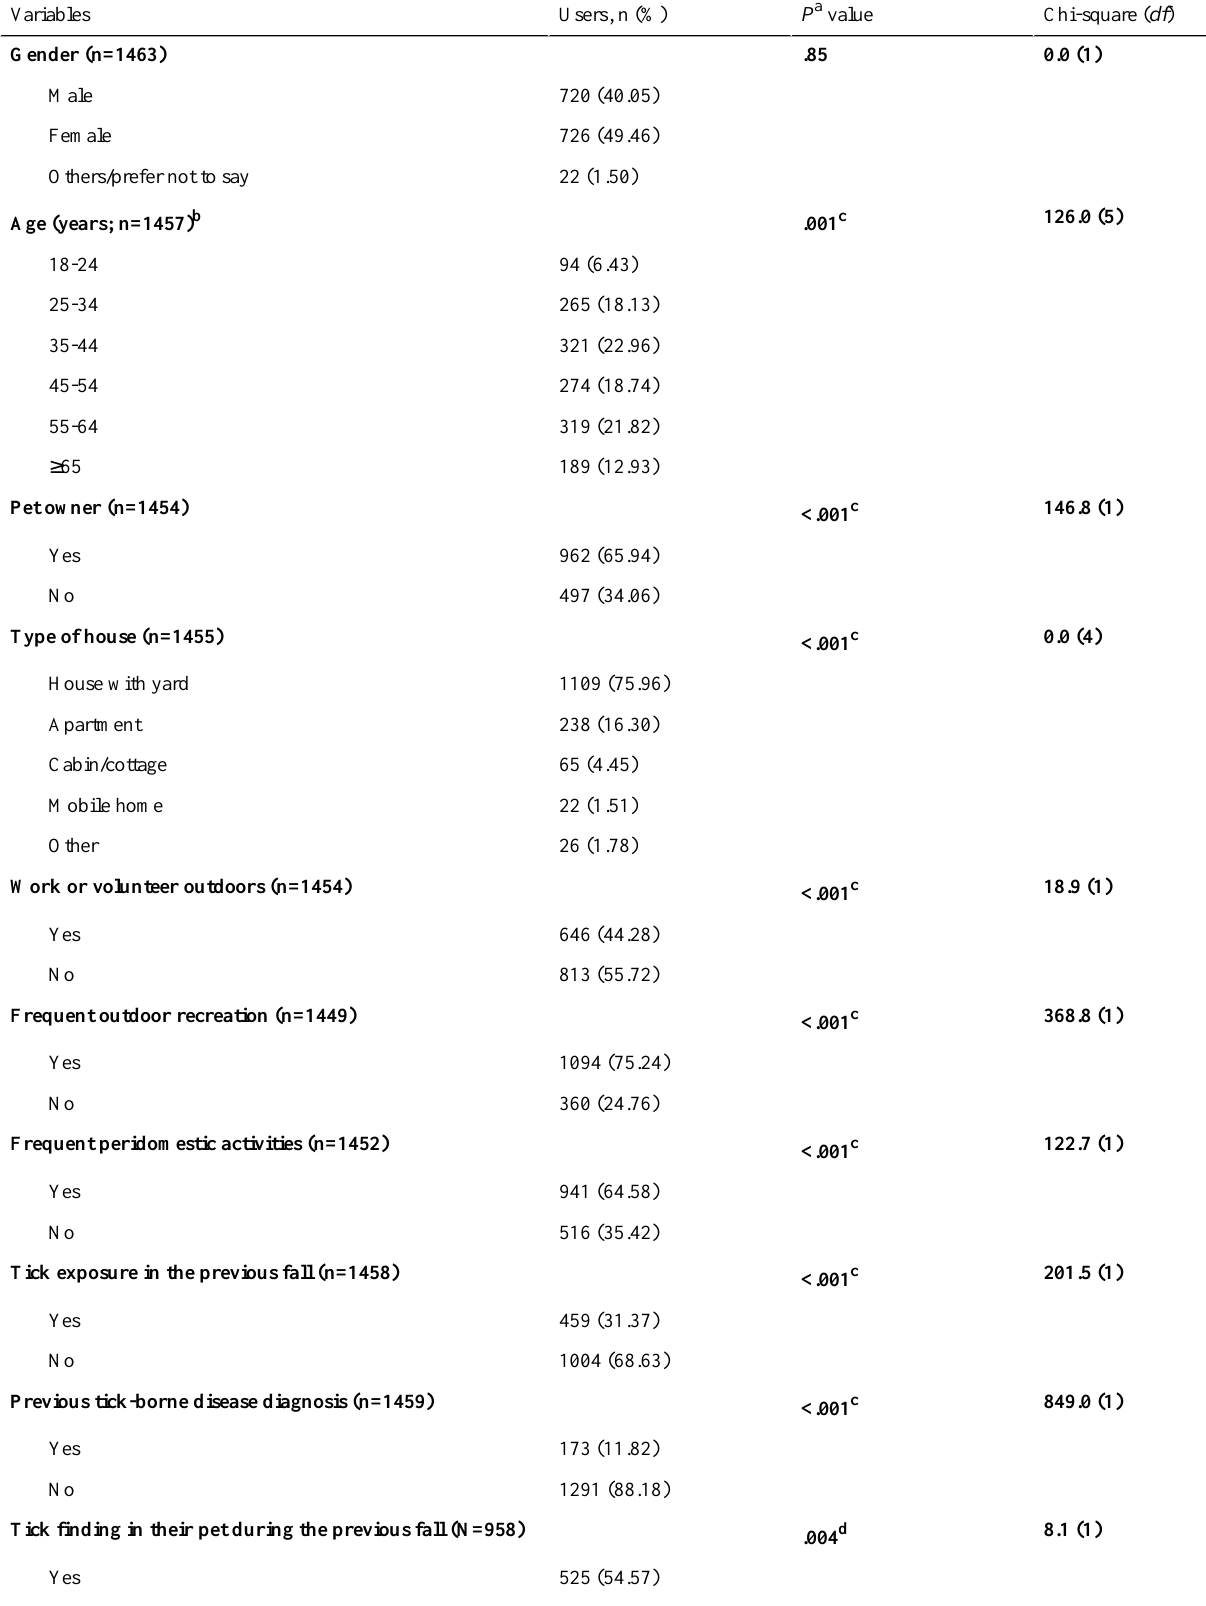
Table 2. Users’ profile including demographic variables, type of property, frequent outdoor activities (occupational, recreational, and peridomestic), and previous experience with ticks and Lyme disease, as reported in the enrollment